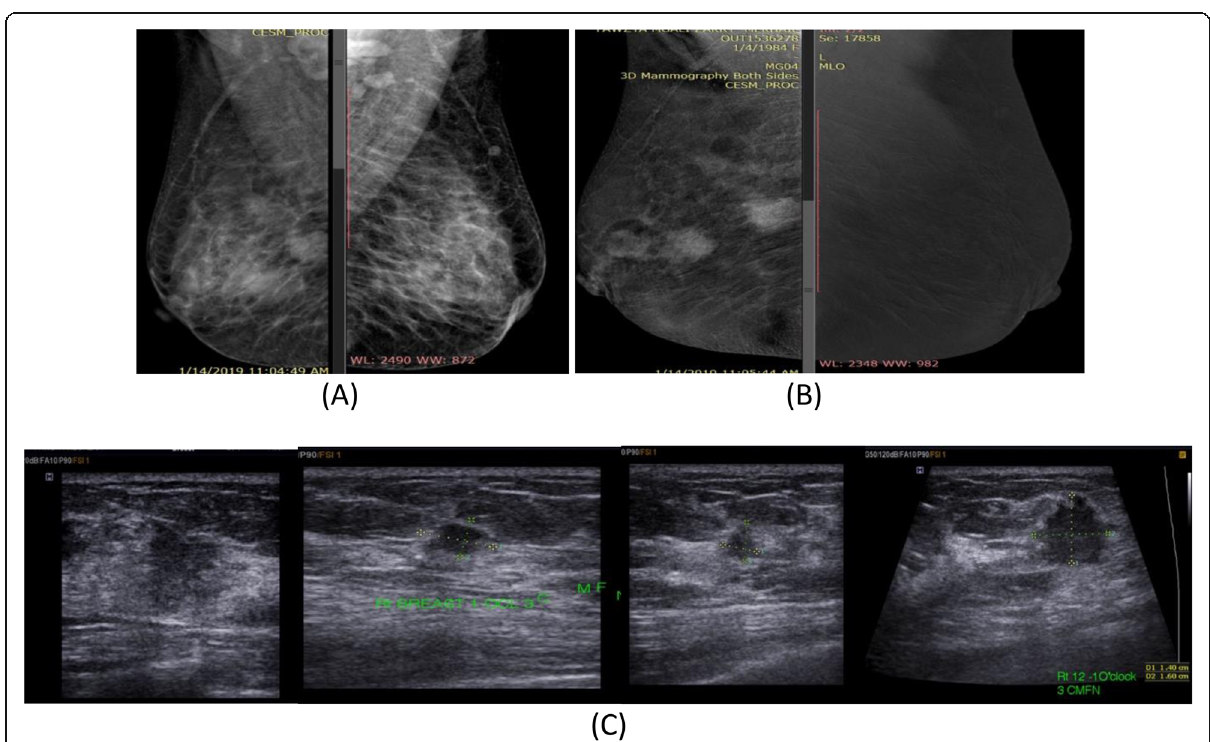
Fig. 3 35-year-old female complaining of lumpy right breast. A Low-energy CESM showed heterogeneously dense breast parenchyma reducing mammographic sensitivity, however with asymmetric densities appreciated deeply seated retroglandular at central and superior aspects of the right breast on MLO view. B Recombined images showed multiple avidly enhancing mass lesions in the right breast concerning for multifocal disease. C Targeted ultrasound examination of the right breast proved the multifocality of the disease.Histopathology revealed IDC (invasive ductal carcinoma) grade 2